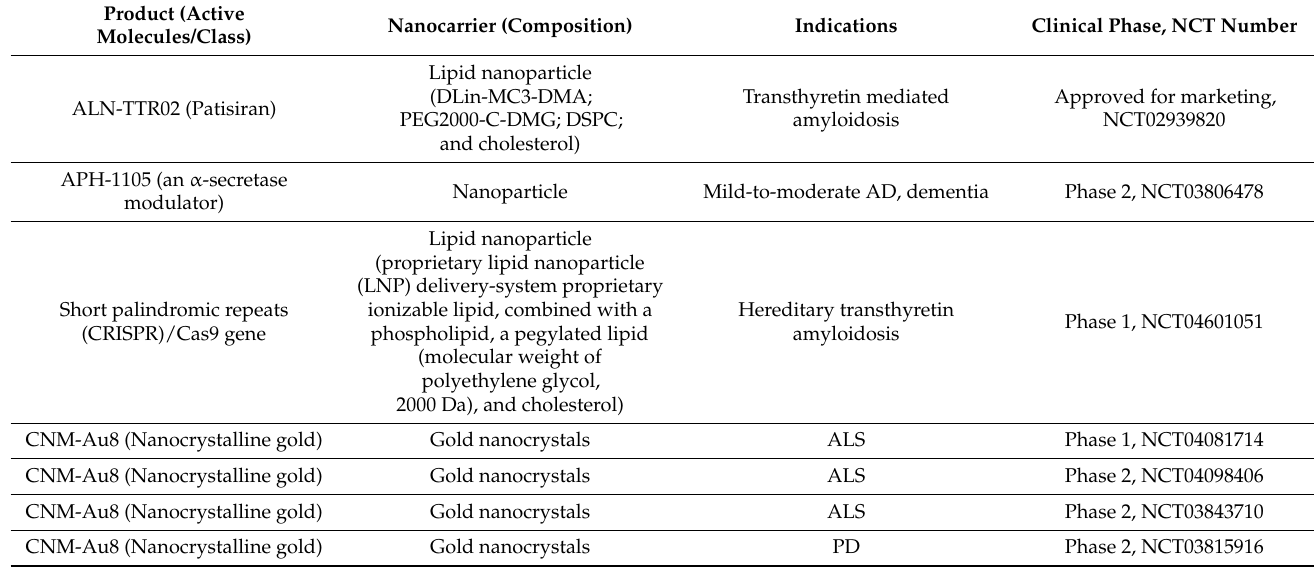
Table 2. Nanocarrier-mediated formulation under clinical trials against different neurodegenerative disorders (ClinicalTrials.gov accessed on 31 January